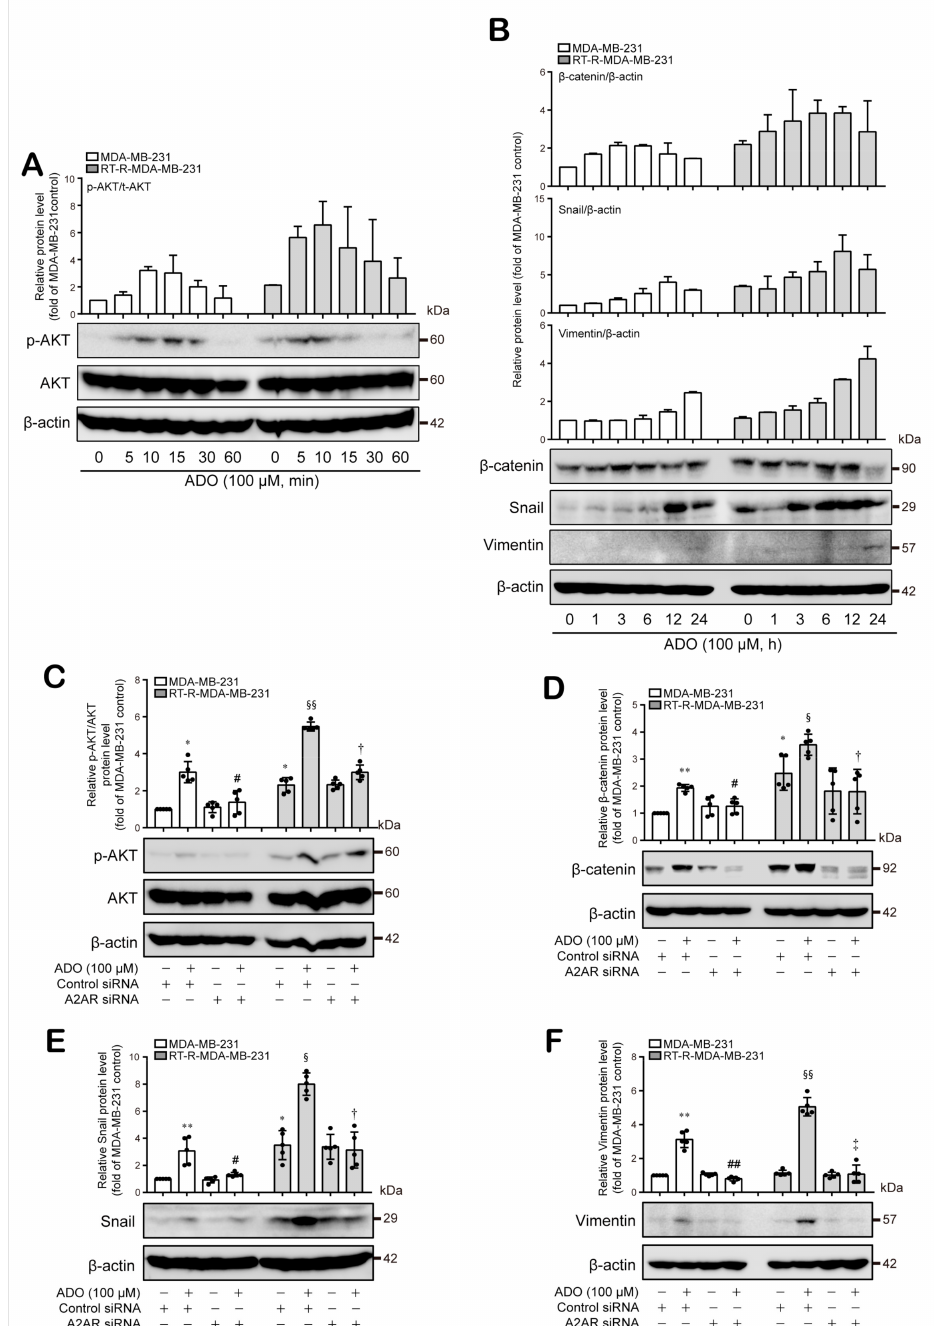
Figure 5. Extracellular ADO activated AKT pathway and mediated β -catenin, Snail, and vimentin expression in MDA-MB- 231 and RT-R-MDA-MB-231 cells. ( A,B ) Cells were time-dependently treated with ADO (100 µ M), and the p-AKT, AKT ( A ), β -catenin, Snail, vimentin, and β -actin protein levels ( B ) were analyzed by Western blotting. The results were confirmed by repeated experiments. ( C – F ) Cells transfected with CTRL siRNA or A2AR siRNA were treated with ADO for 10 min (AKT), 6 h ( β -catenin), 12 h (Snail), and 24 h (vimentin) for the detection of each molecule. Then, cells were harvested, and the p-AKT, AKT, β -catenin, Snail, vimentin, and β -actin protein levels in the lysates were analyzed by Western blotting, and the band intensities were assessed by scanning densitometry. The values were represented as the means ± SD of 5 independent experiments. * p < 0.05, ** p < 0.01 compared to the control of MDA-MB-231; # p < 0.05, ## p < 0.01 compared to the ADO treatment of MDA-MB-231; § p < 0.05, §§ p < 0.01 compared to the control of RT-R-MDA-MB-231; † p < 0.05, ‡ p < 0.01 compared to the ADO treatment of